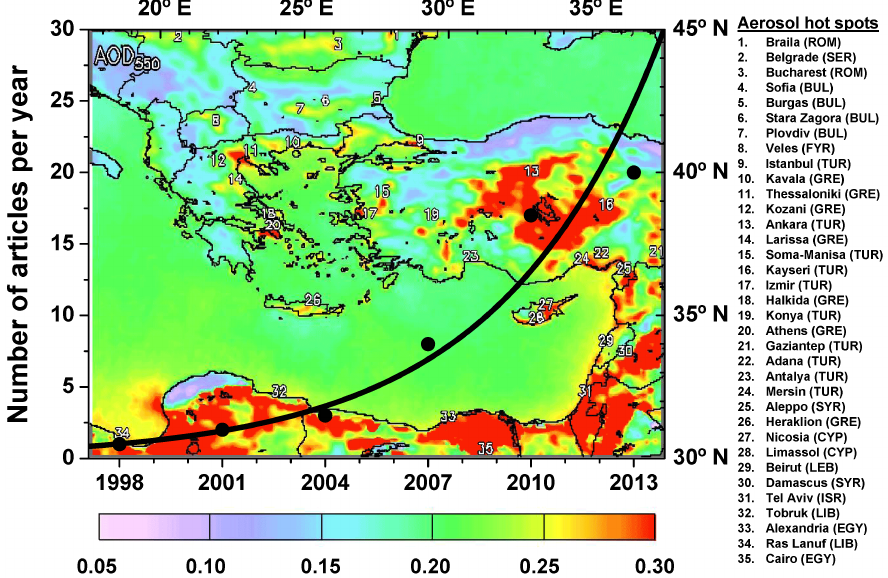
Figure 4. AOD 550 patterns over the Eastern Mediterranean as seen by MODIS Terra during the period March 2000–December 2012 (March 2000–December 2007 for regions of northern Africa covered by DB data only). The color scale corresponds to the AOD 550 lev- els, while the top x axis and the right y axis correspond to the longitude ( ◦ E) and latitude ( ◦ N), respectively. The position of 35 aerosol hot spots is marked on the map (numbers from 1 to 35), while the names of the places and the countries where the hot spots are located appear on the right of the map. In the same figure, the exponential growth of the number of satellite-based articles focusing on aerosols over the greater Eastern Mediterranean from 1997 to 2014 is shown (black line). The black dots represent the number of articles published within 3-year intervals. The bottom x axis and the left y axis correspond to the years and the number of published articles, respectively. The exponential growth corresponds to a near doubling of the publication rate every 3 years. Table 3. AOD 550 levels, the corresponding ± 1 σ values and the number of gridded values used for the calculations over the Eastern Mediter- ranean (EMT), over the land-covered part (EML), over the oceanic part and over the nine subregions of the Eastern Mediterranean appearing in Fig. 1 based on the MODIS Terra and Aqua (italics) observations. Region No. of